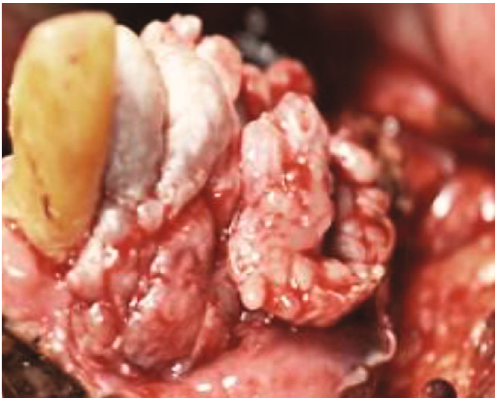
Figure 5: Clinical image showing a wide local surgical excision performed under local anaesthesia.